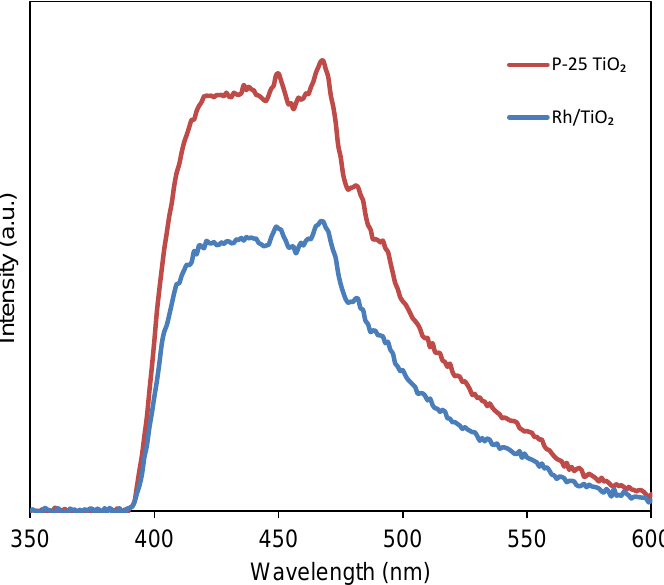
Figure 10. Photoluminescence spectra of P-25 TiO 2 and Rh/TiO 2 .